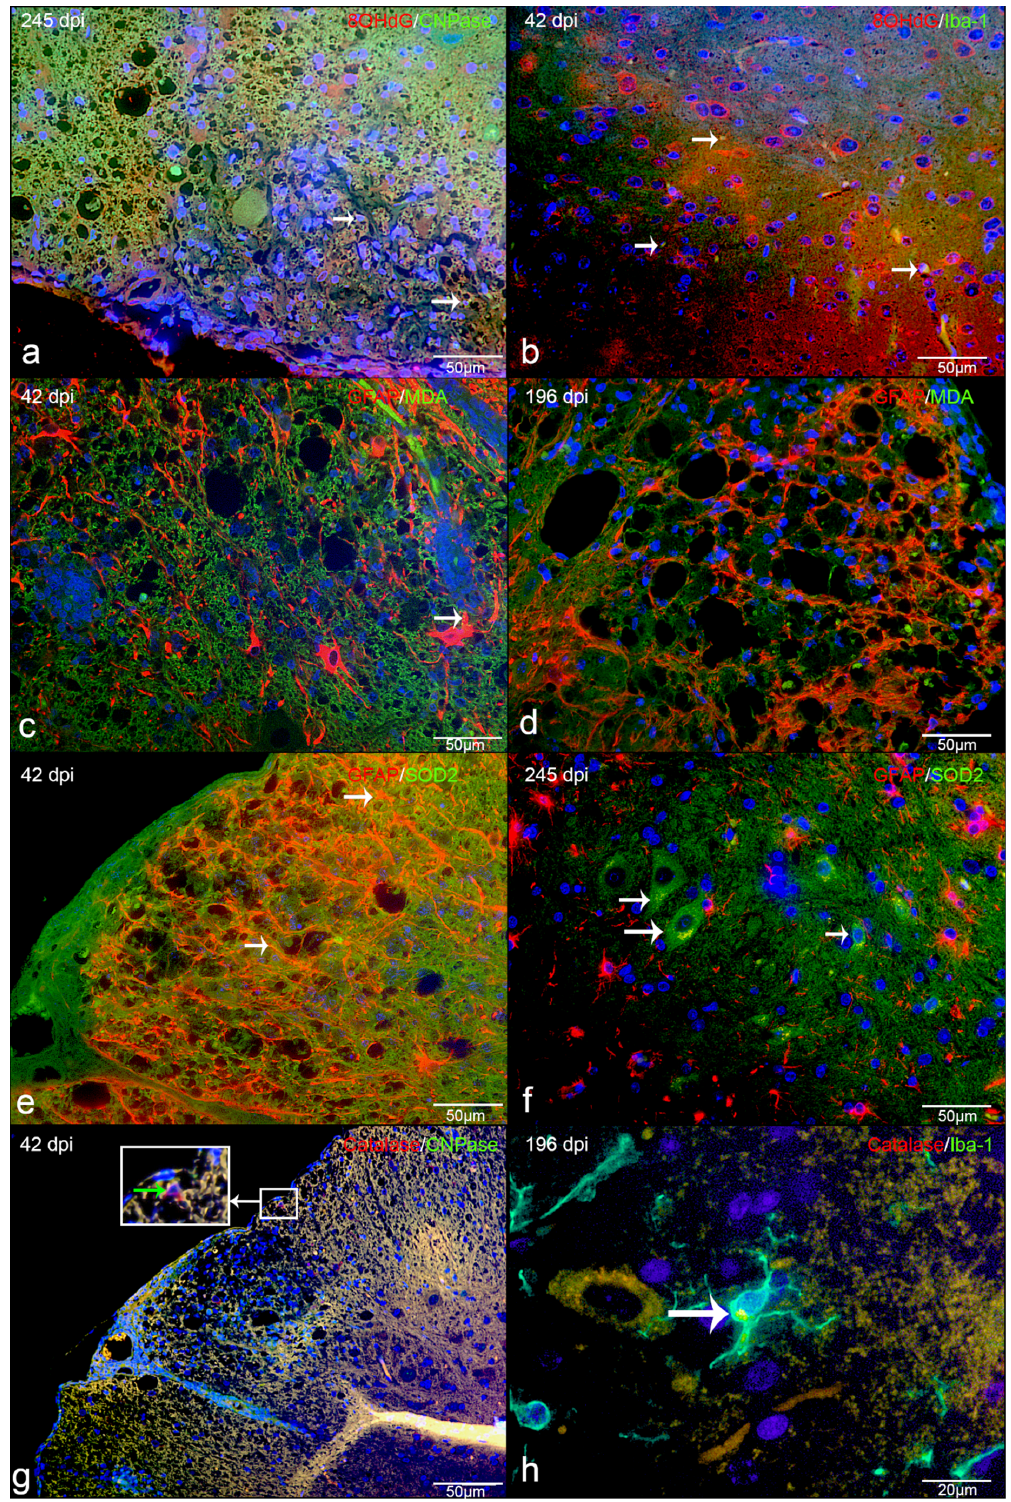
Figure 8. Immunofluorescence in TMEV-DL lesions: ( a ) 8OHdG and CNPase as well as oligodendrocytes positive for 8OHdG (double labeling, yellow, arrow) in the white matter of spinal cord of TMEV-DL, ( b ) 8OHdG and Iba1, showing that macrophages/microglia are positive for 8OHdG (double labeling, yellow, arrow) in TMEV-DL, ( c ) MDA and GFAP double labeling (yellow, arrow) in TMEV-DL, ( d ) MDA and GFAP, showing that astrocytes do not significant co-localize with MDA (double labeling, yellow)